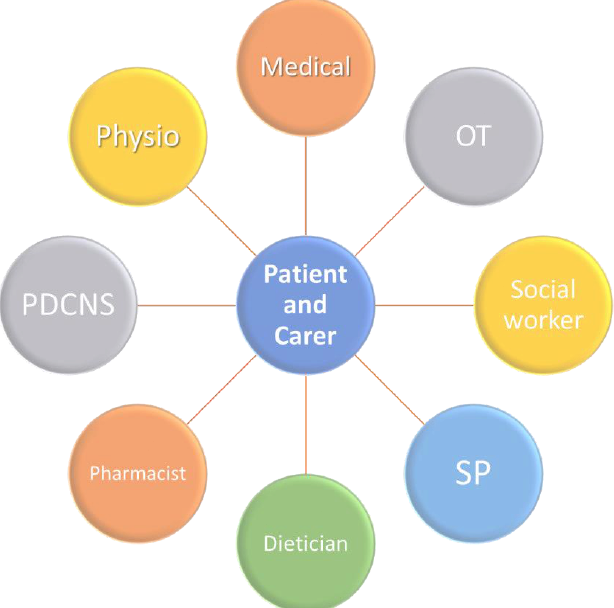
Figure 2. Model of care for the older person with PD. PDCNS: Parkinson’s Disease Clinical Nurse Specialist; SP: Speech Pathologist; OT: Occupational Therapist; Physio: Physiotherapist.